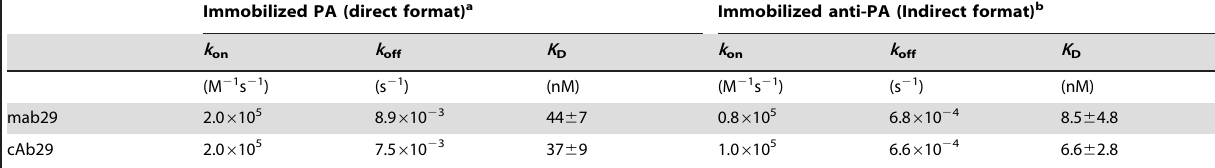
Table 2. Binding kinetics of the PA-specific antibodies.